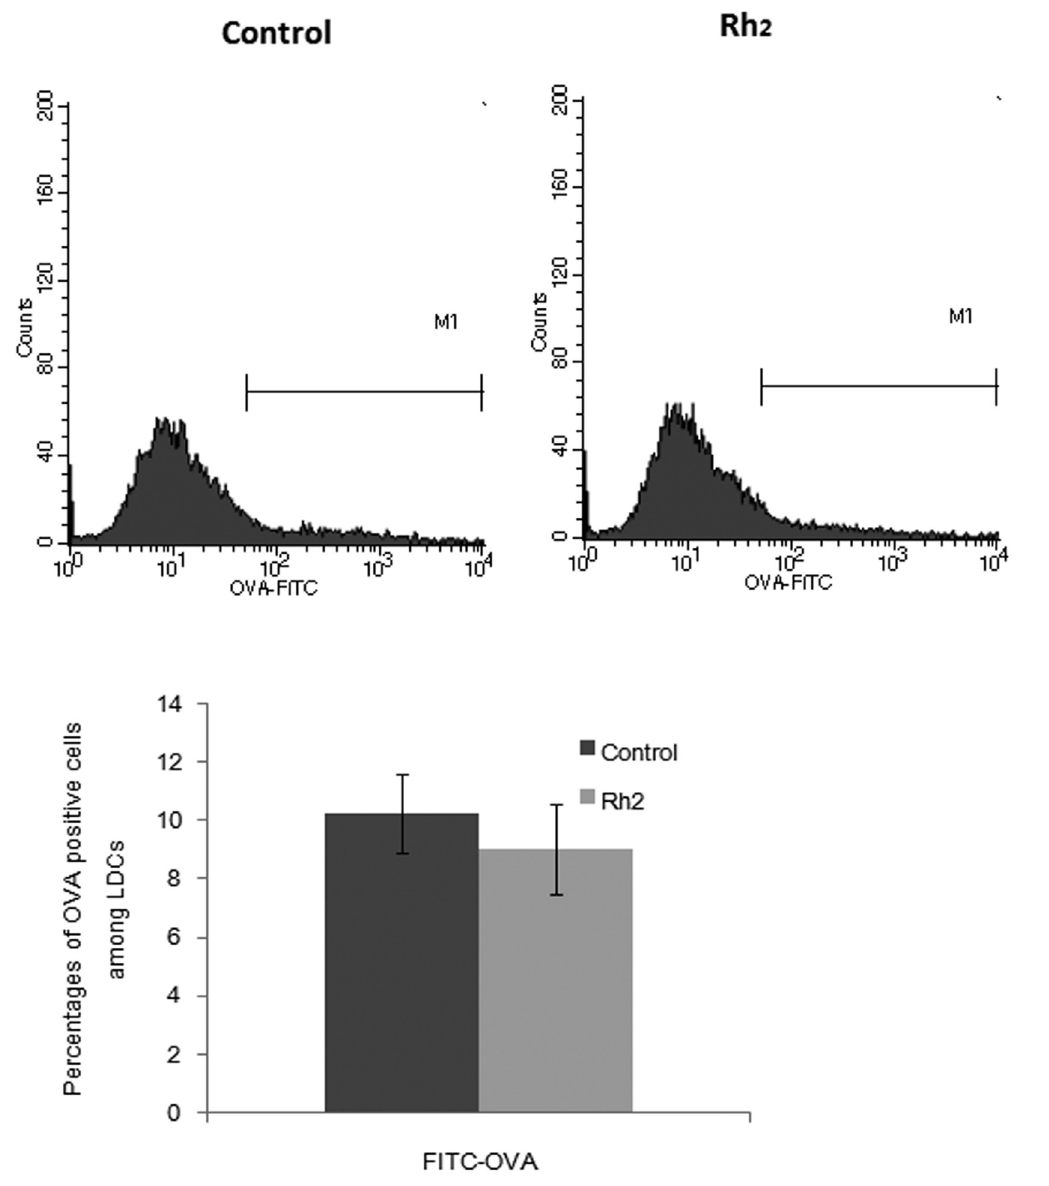
on endocytic activity of LDCs. Percentages of OVA positive cells among LDCs reflect the antigen uptake Figure 6: Effects of ginsenoside Rh 2 of LDCs. (Mean ± SD, N=3), * P<0.05 vs. control; ** P<0.01 vs.